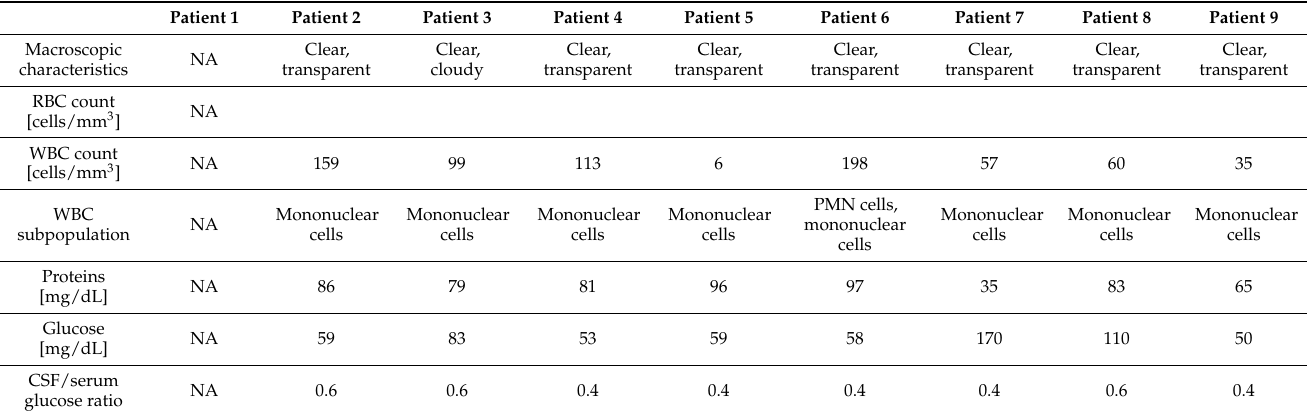
Table 2. Cerebrospinal fluid analysis and chemical-physical